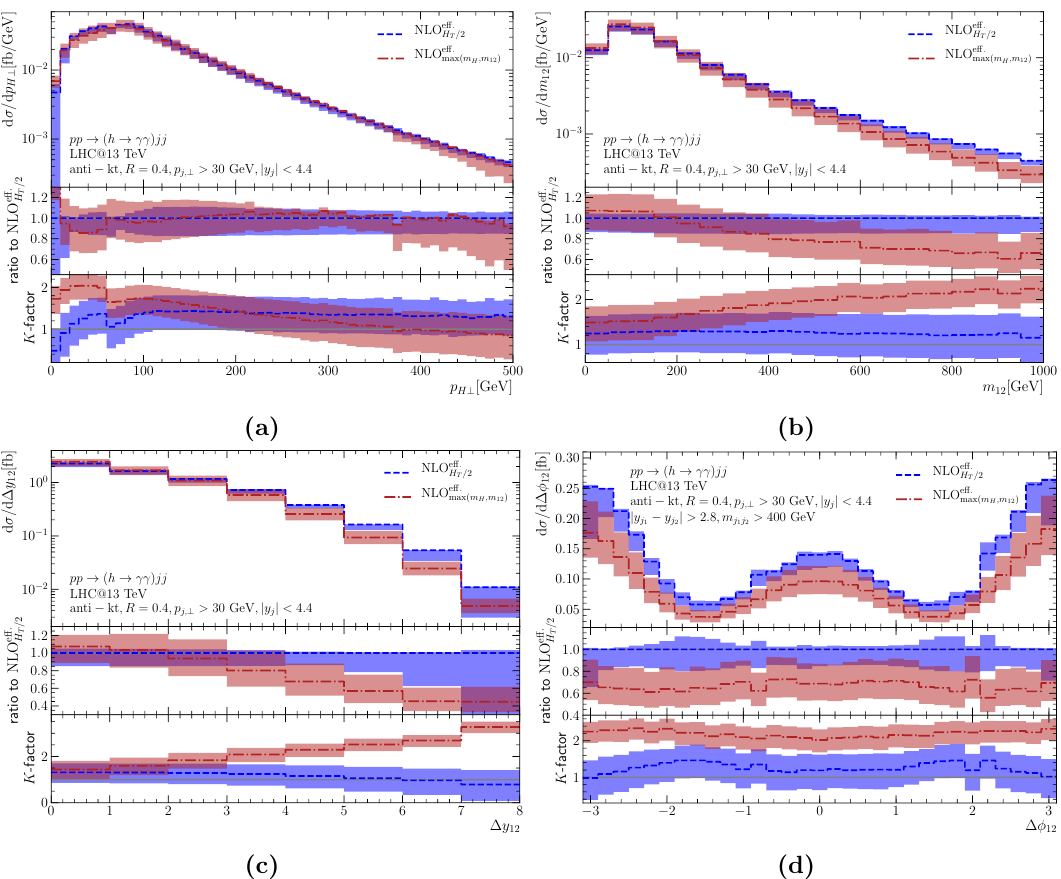
Figure 16 . Comparison between pure NLO results with central scale choices (cid:22) (cid:22) r = (cid:22) f = max( m H ; m 12